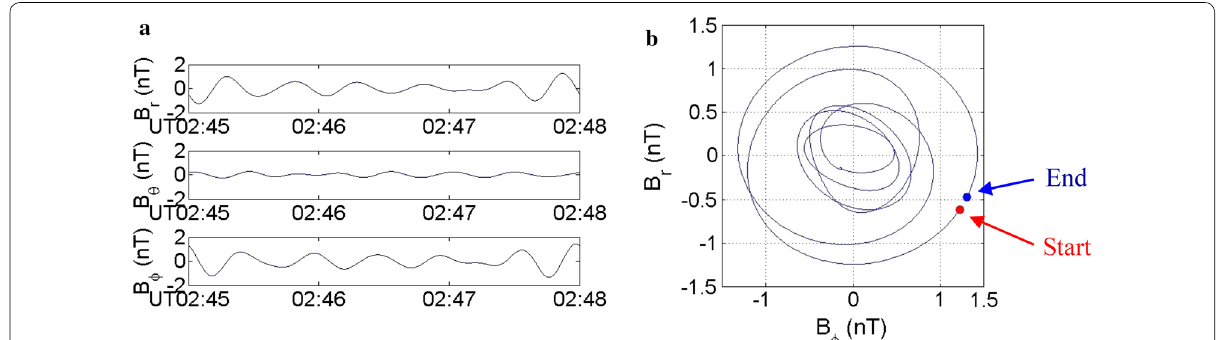
Fig. 4 An ion cyclotron wave event for R > 6 R S on September 30, 2007. a Perturbed magnetic field components in the KRTP coordinates, B 0 ~50 nT, and b the left-hand circular polarization of the magnetic field components. The red point denotes the start time and the blue point denotes the end